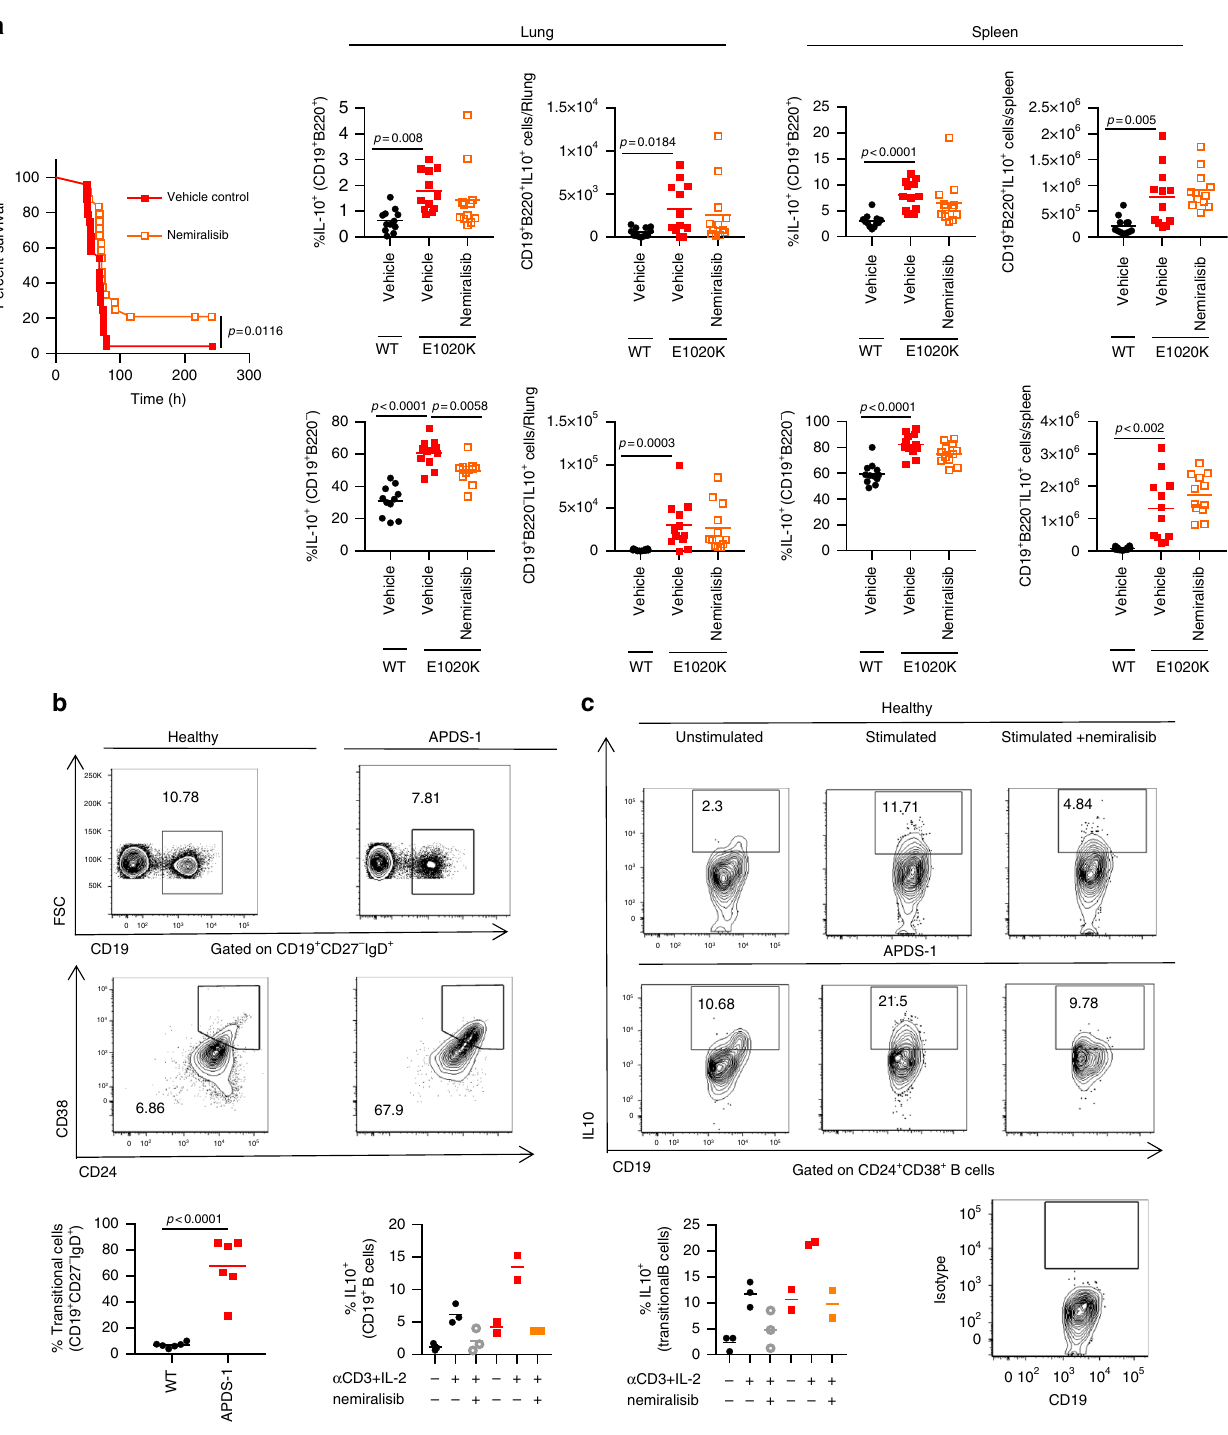
Fig. 10 Nemiralisib treatment reduces the proportion of IL-10 producing B cells in mice and humans. a Prophylactic treatment with nemiralisib improved survival in p110 δ E1020K-GL mice and was associated with a signi fi cant reduction in the proportion of IL-10 producing B220 − B cells in the lung at 24 h post- infection. ( a Combined data from two independent studies, survival n = 24; lung tissue analysis n = 12, mean cell number shown, data-points represent individual animals) b Blood from patients with APDS ( n = 6) and healthy controls ( n = 6) was obtained and the B cell phenotype was determined by fl ow cytometry. Transitional B cells are identi fi ed as CD19 + IgD + CD27 − CD24 + CD38 + . Representative contour plots with outliers show the mean proportions of cells. c Freshly isolated PBMCs were unstimulated or stimulated with plate bound anti-CD3 and anti-IL-2 for 72 h in the presence or absence of nemiralisib ( n = 2 – 3). The proportion of IL-10 producing cells among the total B cell and transitional B cell populations was determined by fl ow cytometry. Representative contour plots with outliers show mean proportions of IL-10 producing cells. (Mean cell proportions are shown, data-points represent individual patients; Combined data from two independent